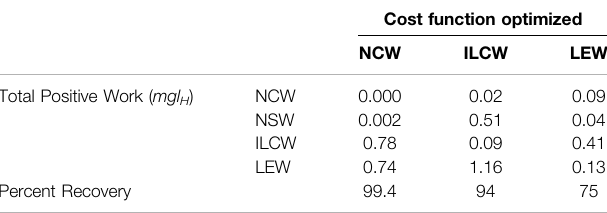
TABLE 1 | Positive work under various candidate cost functions, for simulations optimizing each cost function under a distributed mass